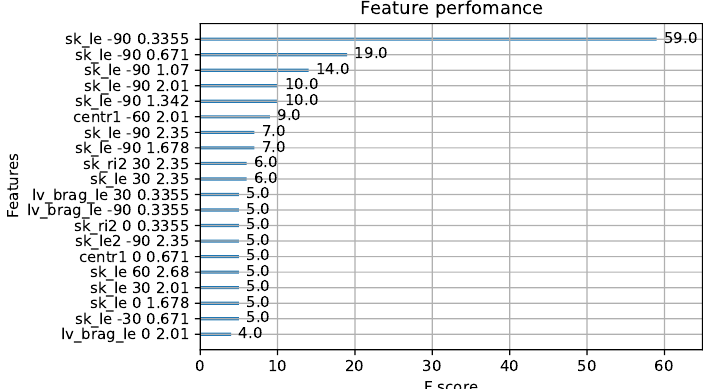
Figure 11. Twenty most important features reported by the XGBoost algorithm. Frequency = 2720 Hz, number of estimators = 20. The importance means how many times the feature was used in the decision trees to split the